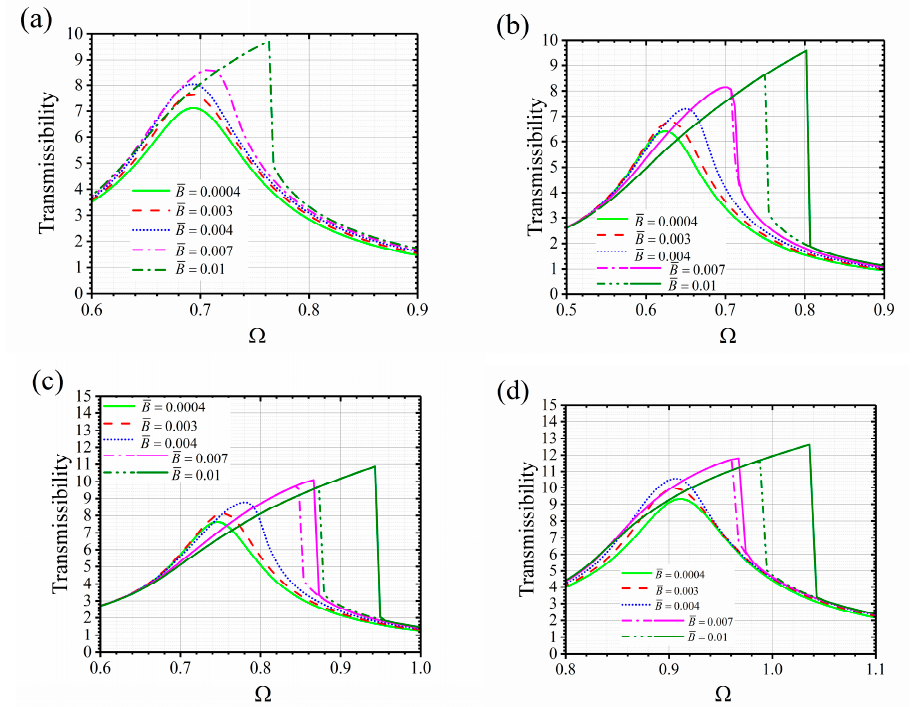
Figure 7. The influence of load weight on the transmissibility of the isolator. ( a ) The dimensionless load weight is 1.34. ( b ) The dimensionless load weight is 1.55. ( c ) The dimensionless load weight is 1.96. ( d ) The dimensionless load weight is 2.08.